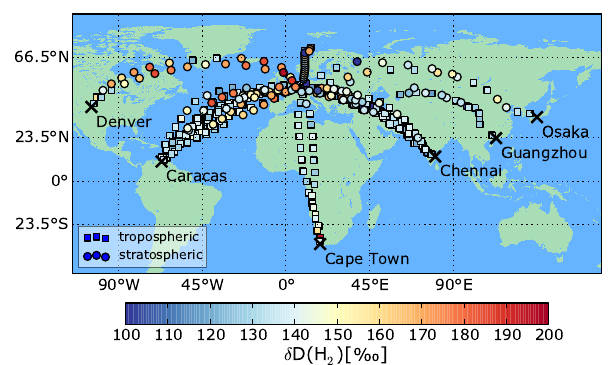
Fig. 1. Sampling locations of all samples. The color scale indicates the measured value of δ D. The destination airports of the flights are indicated with black crosses and names. Marker type indicates if the sample is tropospheric ( (cid:3) ) or stratospheric ( ◦ ), as determined by the O 3 -derived height above the tropopause (TP) (Sprung and Zahn , 2010). Some polluted samples are off the scale ( δ D <